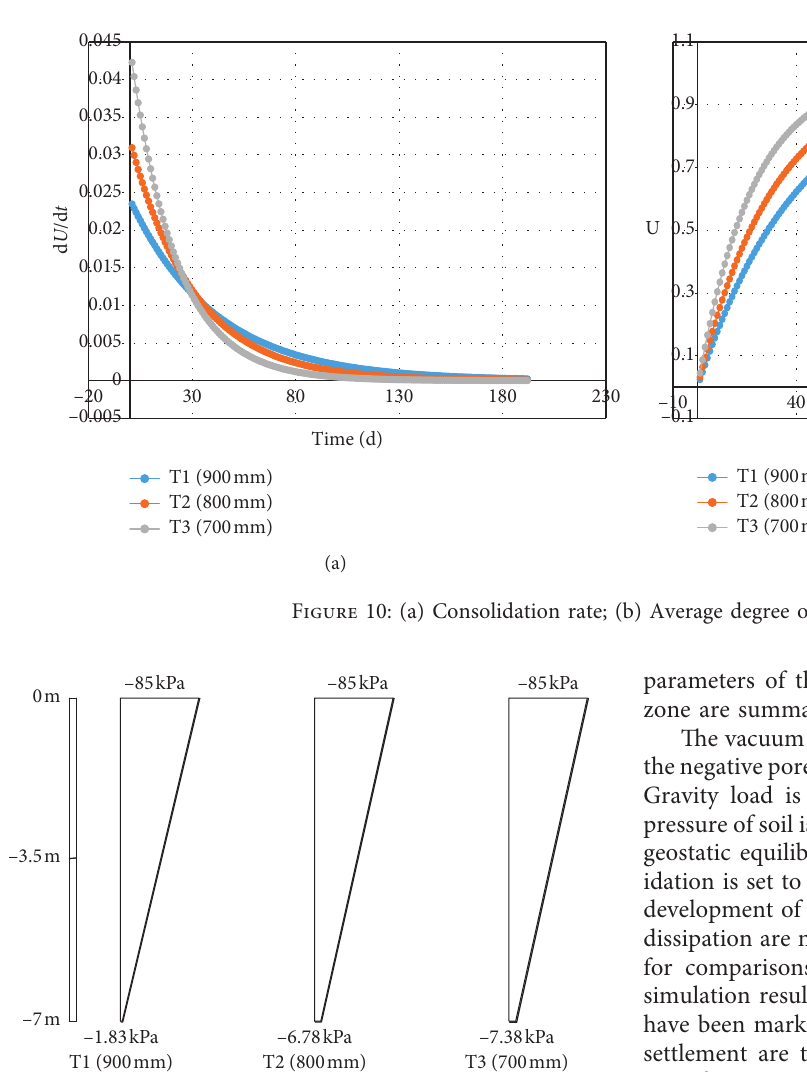
Figure 11: Vacuum pressure distribution along